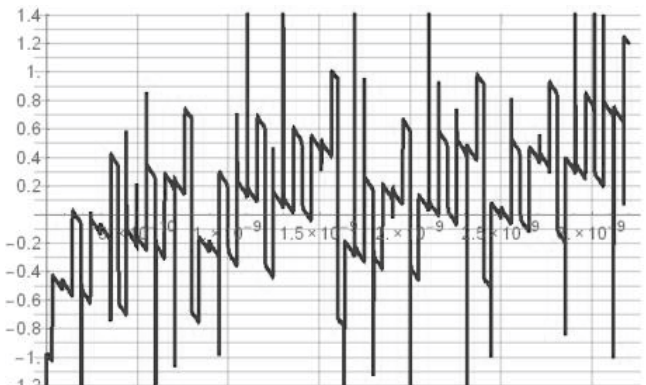
Figure 30. Total delay error normalized to LSB ( T 0 ) introduced by multiplexers S Si and S R i vs. input time interval T In for 8-bit SA-TDC with T m = 250 ps.